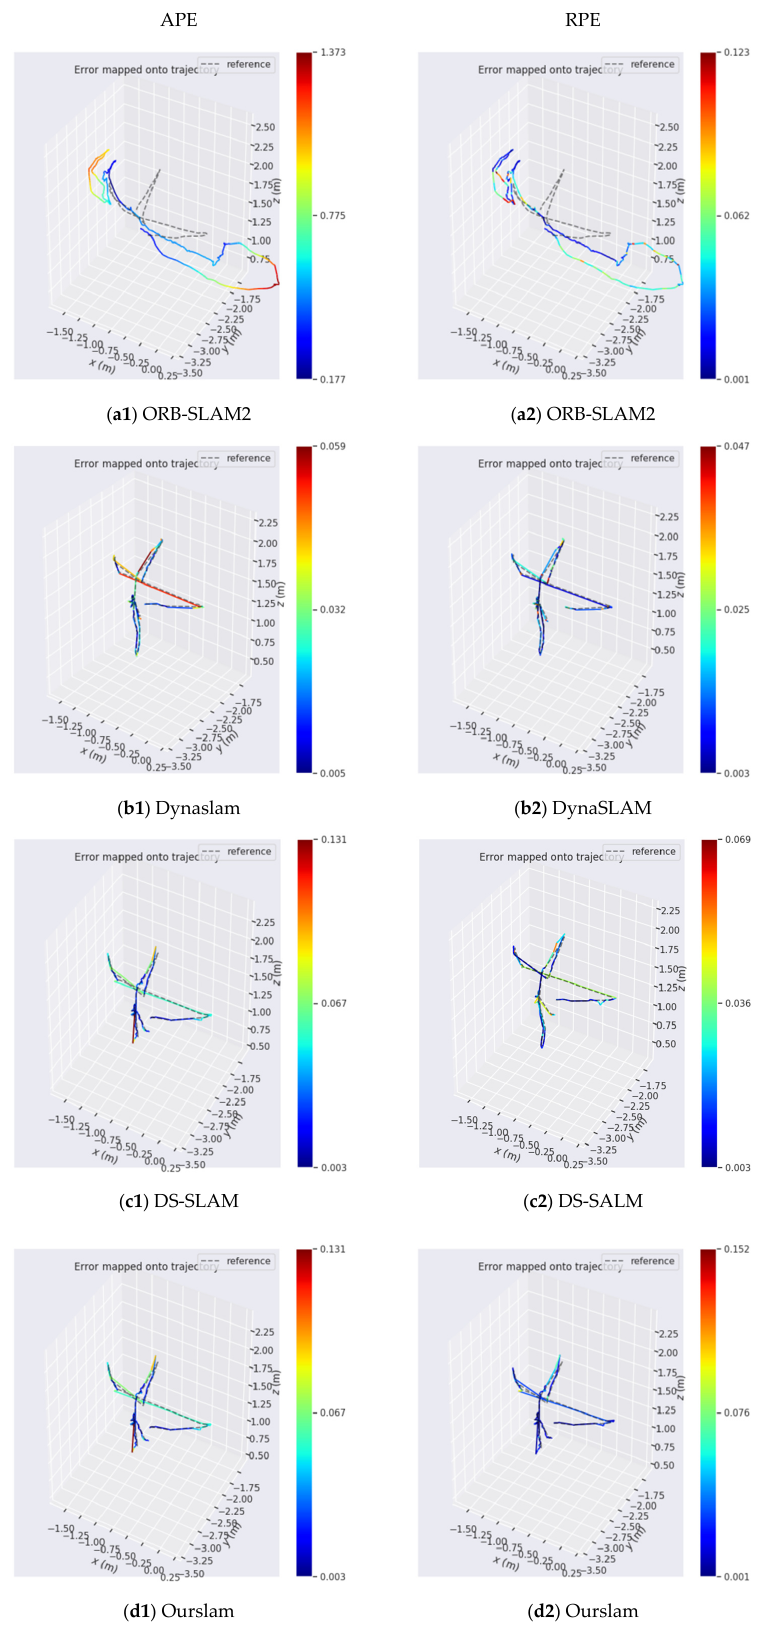
Figure 12. Error mapping to trajectory results of ORB-SLAM2, DynaSLAM, DS-SLAM, and OurSLAM on dataset fre3_walking_halfsphere.